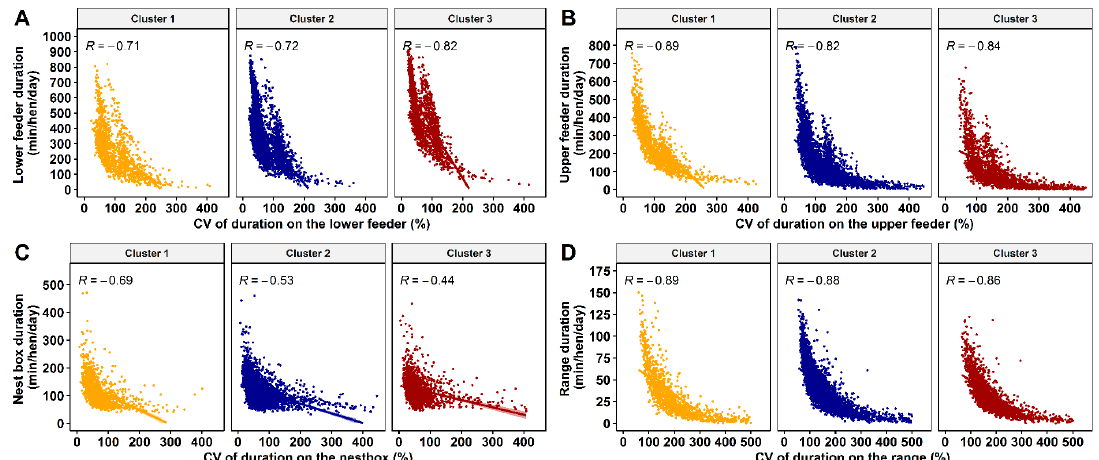
Figure 6. The bivariate correlation plot of coefficient of variation for the daily duration and mean daily duration for cluster 1 (orange), 2 (dark blue), and 3 (dark red) based on K-means solution for lower feeder zone ( A ), upper feeder zone ( B ), nest box ( C ) and outdoor range ( D ). Each dot represents each hen in clusters 1, 2, and 3, while the shaded area around the correlation line represents the confidence interval. All correlation coefficients are significant with p -values < 0.0001.